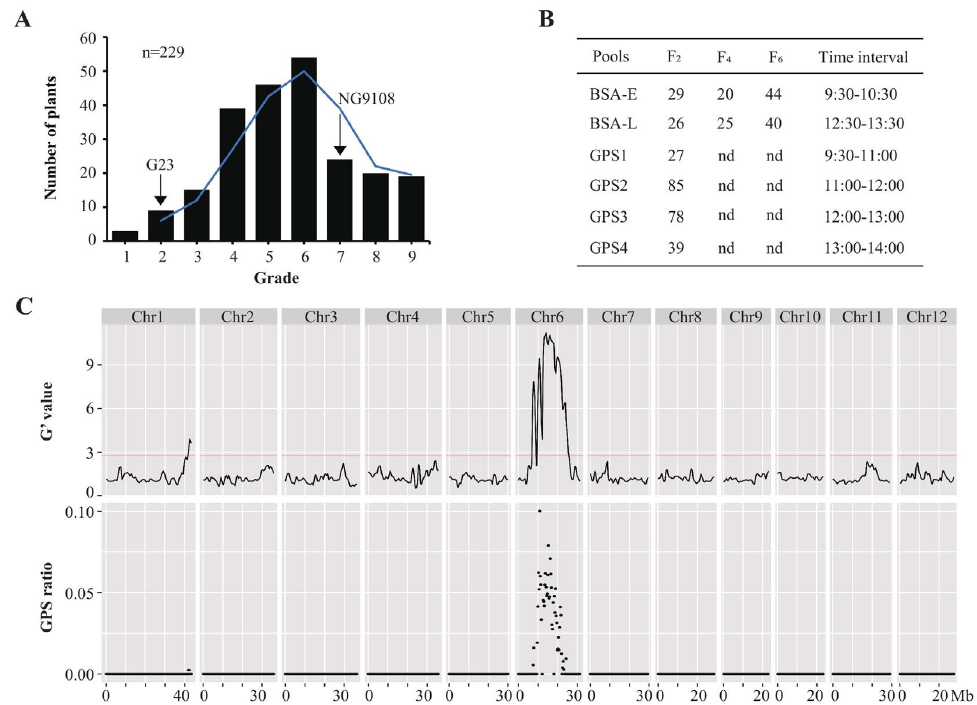
Figure 2. Genetic analysis and QTL mapping of FOT in G23. ( A ) Frequency distribution of FOT in the F 2 population derived from a cross between G23 and NG9108. For X -axis value: grade 1: 9:30–